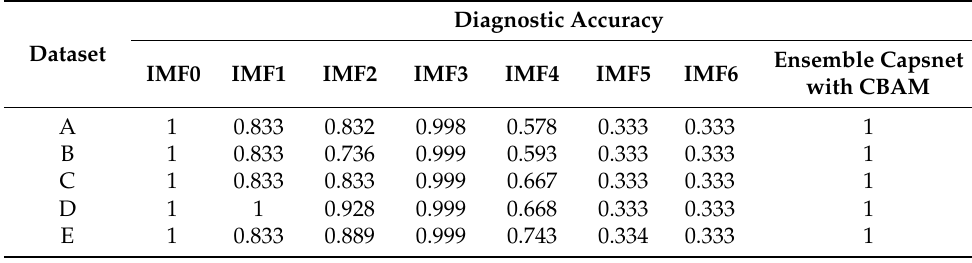
Table 2. The diagnostic accuracy of testing samples.